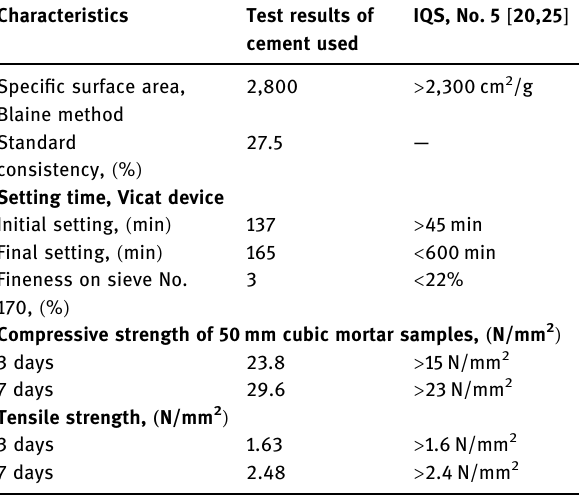
Table 1: Physical and mechanical characteristics of cement